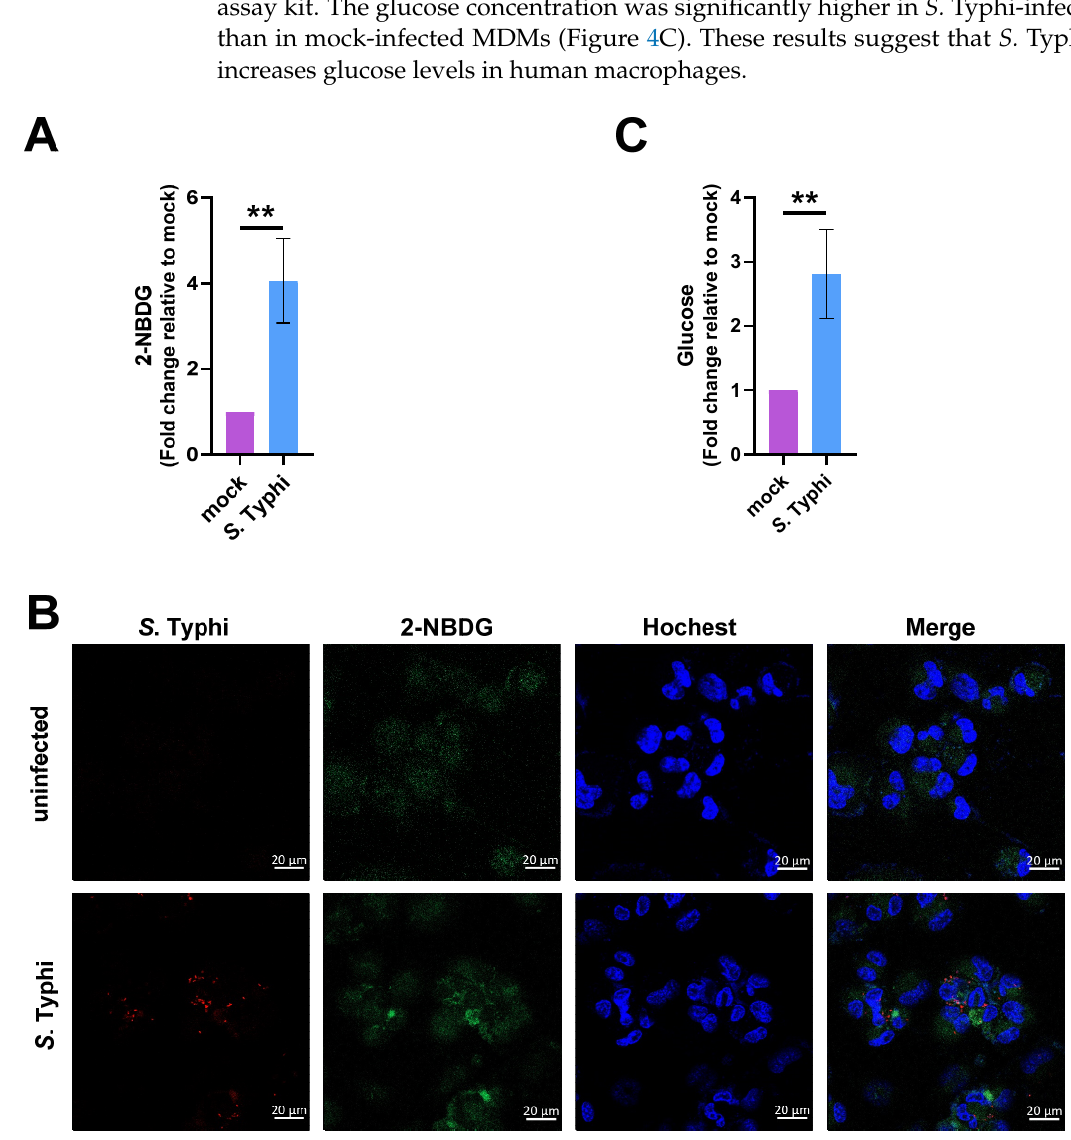
Figure 4. Salmonella enterica serovar Typhi ( S. Typhi) infection increases the glucose level in human macrophages. ( A ) Glucose uptake assay in mock-infected or S . Typhi-infected THP-1 cells in glucose-depleted RPMI-1640 medium, using the fluorescent glucose analog, 2-( N -(7-nitrobenz-2-oxa-1,3-diazol-4-yl) amino)-2-deoxyglucose (2-NBDG). ( B ) Representative images from three independent experiments showing 2-NBDG distribution in mock-infected or S . Typhi-infected THP-1 cells. Red, S . Typhi; green, 2-NBDG; blue, nuclei. Scale bars represent 20 µ m. ( C ) Glucose uptake in mock-infected and S . Typhi-infected THP-1 cells. ( A , C ) Data were obtained from three independent experiments and analyzed using Student’s t -test. ** p < 0.01.